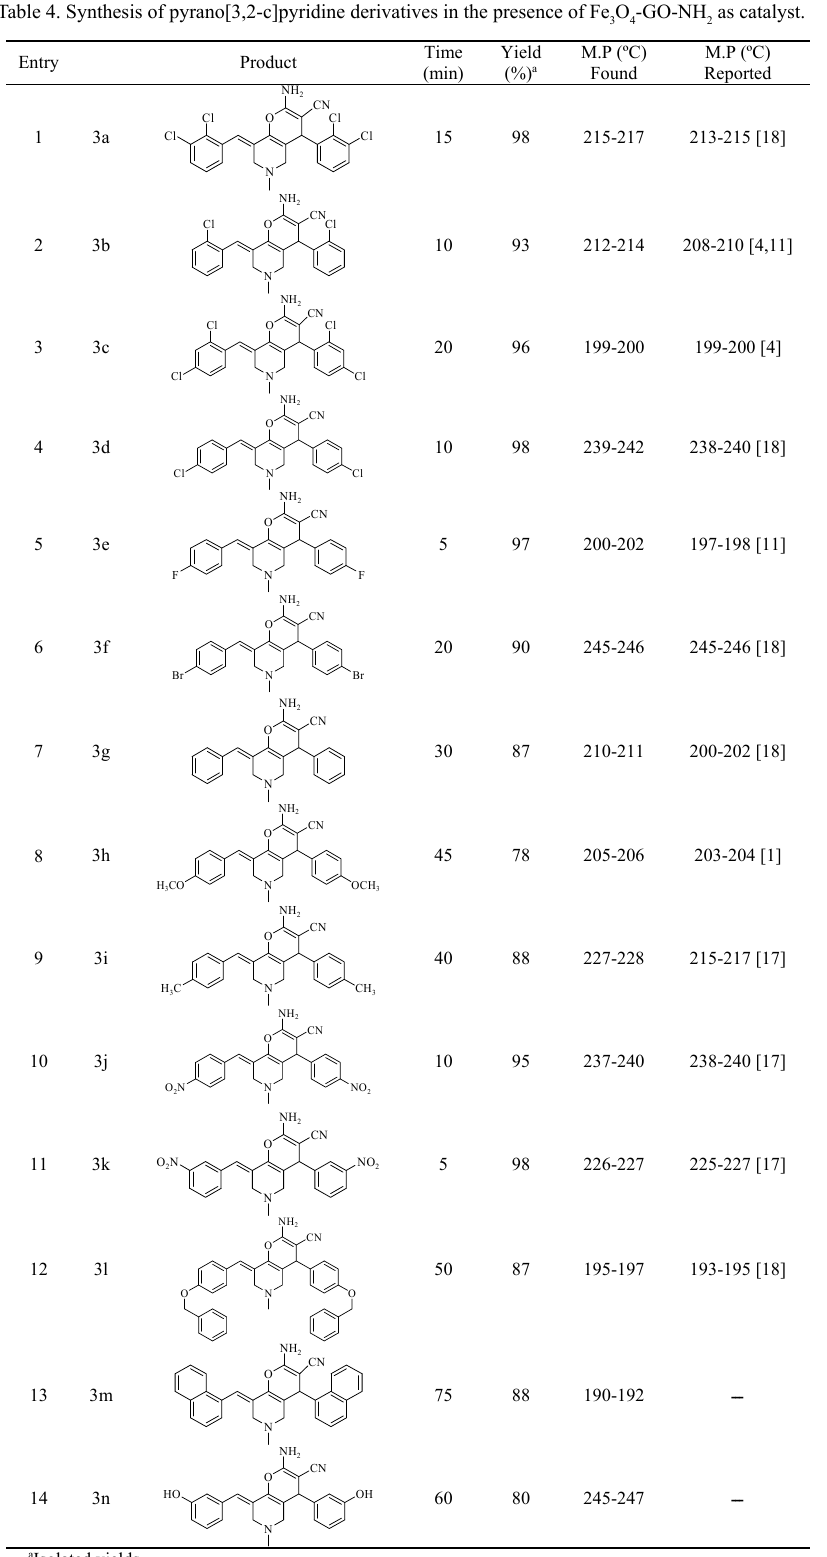
Table 4. Synthesis of pyrano[3,2-c]pyridine derivatives in the presence of Fe 3 O 4 -GO-NH 2 as catalyst.